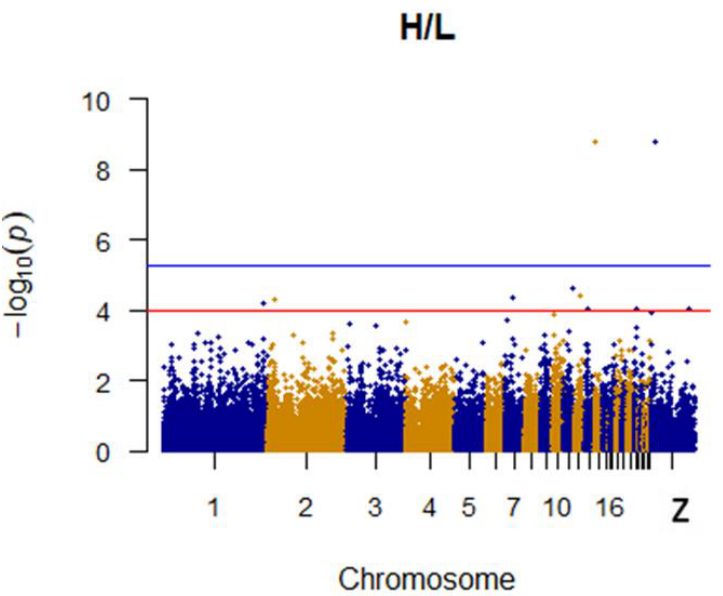
Figure 5. Manhattan plot for H/L in chicken. The x-axis is the position of each single